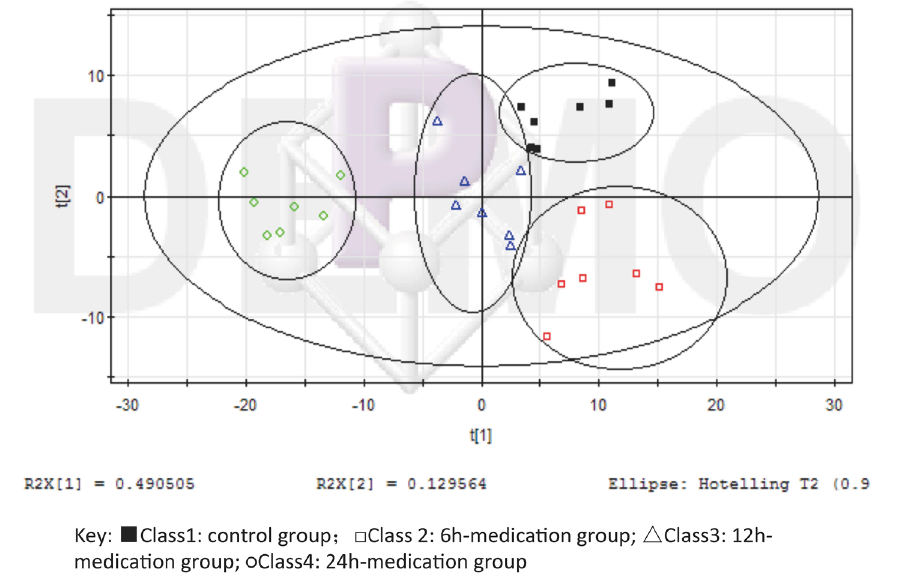
FIGURE 8 - Score plot of the first two values of the proton nuclear magnetic resonance ( 1 H NMR) spectra of serum samples from the control and medication groups (6-h, 12-h, and